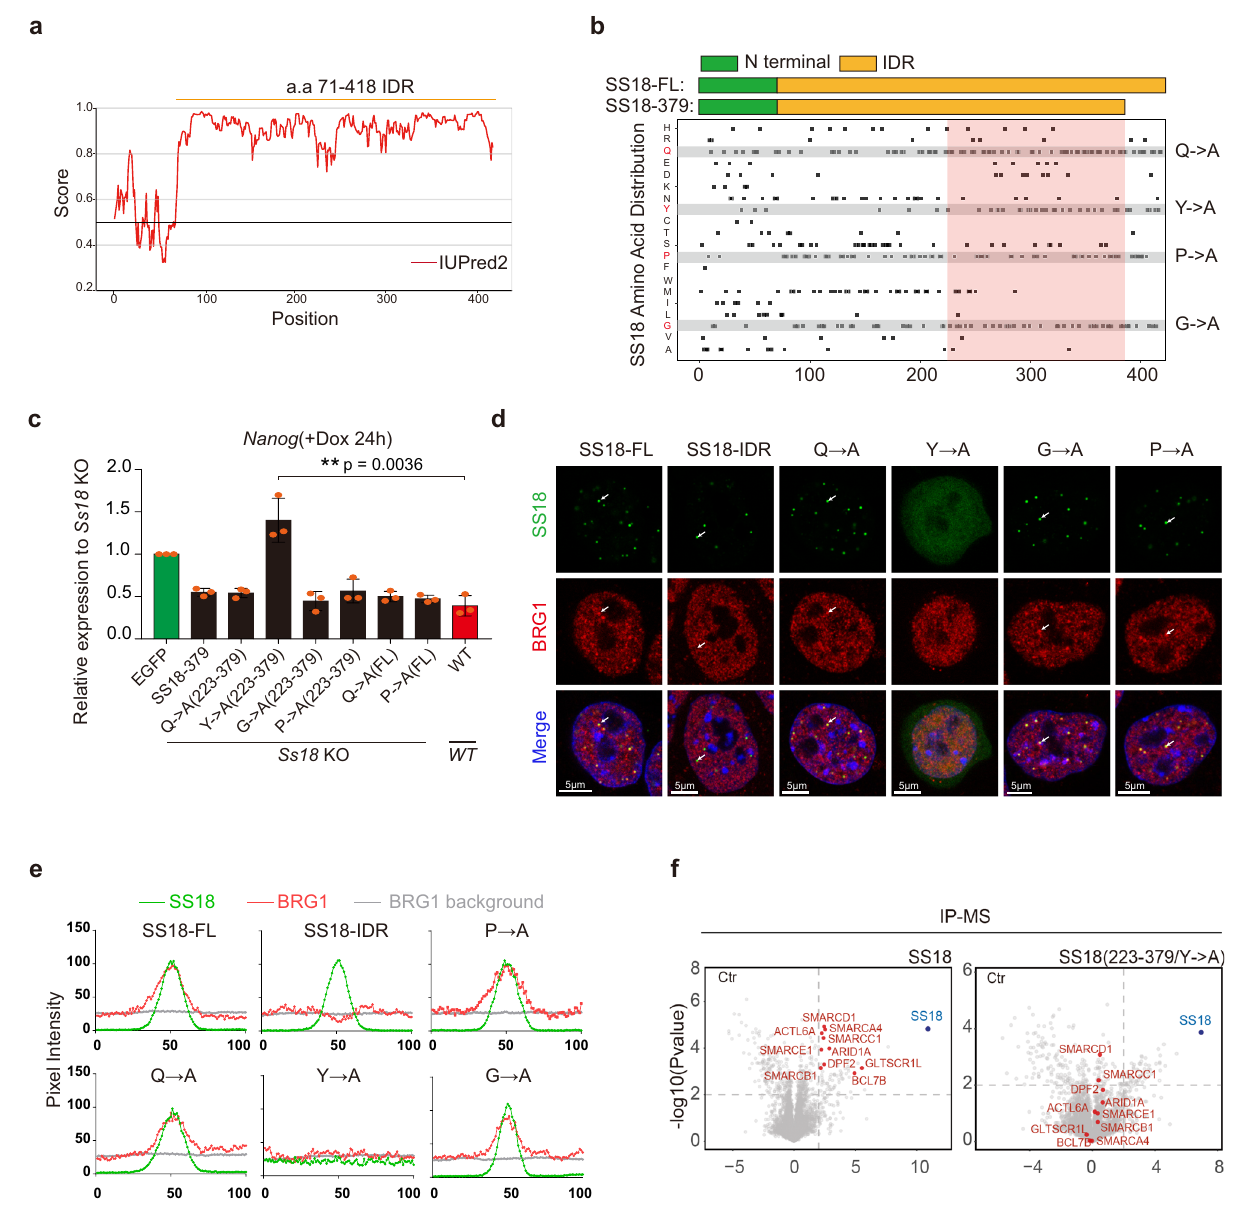
Fig. 4 SS18 condensates through a tyrosine-based mechanism. a Graph plotting intrinsic disorder of SS18 by the IUPred2A algorithm (https://iupred2a. elte.hu/). IUPred2 scores are shown on the y axis, and the amino acid positions are shown on the x axis. b Schematic illustration for Ss18 truncations shown in the upper panel with the amino acid distribution of SS18 indicated in the lower panel. The pink box highlights the necessary region of C-terminal for the function of SS18 in PST. Q->A, Y->A, P->A, G->A indicate the amino acid Glutamine, Tyrosine, Proline, Glycine mutated to Alanine, respectively. c The expression of Nanog in Ss18 − / − mESCs overexpressing the indicated Ss18 mutants during c-Jun based PST. Note the failure of Y-A to rescue PST. Data are mean ± s.d., two-sided, unpaired t test; n = 3 independent experiments, ** p < 0.01. d Representative images for the indicated WT, IDR and SS18-mutant- EGFP fusion proteins and immuno fl uorescence imaging for BRG1 in mESCs. Scale bars, 5 μ m. Note the failure of Y-A mutant to form condensates. SS18-EGFP, laser intensity 2.5%, detector gain 500 V. BRG1 immuno fl uorescence, laser intensity 3.5%, detector gain 750 V. Both SS18-EGFP and BRG1 immuno fl uorescence were processed by background subtraction. Eight condensates. e The graphs showing the pixel intensity in Fig. 4d. The green curves indicate the pixel intensity dynamic across six condensates of various SS18 mutants and the corresponding pixel intensity of BRG1 indicated by the red curves; the average pixel intensity of BRG1 within nuclei and outside of the nucleoli were indicated by gray curves. f Volcano plots of IP-MS results for FLAG tagged SS18 and SS18Y-A mutant expressed in SS18 − / − mESCs by anti-Flag antibody with label-free quanti fi cation. SS18 − / − cells serves as control. Every point represents a single protein. SS18 and BAF components are marked blue and red. IP-MS experiments were performed in triplicates and a two-sample t test was applied. P = 0.01 and fold change = 2 are used as threshold. Functional rescue of SS18 IDR . Condensate formation through IDRs, we constructed a set of fusions between the N-terminal domain of SS18 and poly-Y, S centered/enriched IDRs from phase separation is a physic property mediated by several distinct MED1 and P/Q enriched IDRs from BRD4 32 , Y centered/enri- mechanisms 34,35 . Our results from the Y-A mutant further sug- gest that SS18 may rely on Y residues to form condensates ched IDRs from TAF15 and FUS 33 (Supplementary Fig. 5a). We (Fig. 4d). To test if SS18 IDR can be replaced by other types of show that poly-Y, TAF15-IDR and FUS-IDR, but not MED1-IDR NATURE COMMUNICATIONS| (2021) 12:4090